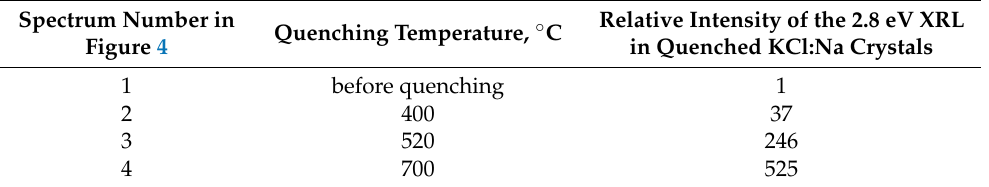
Table 1. Dependence of the peak intensity of XRL with a maximum at 2.8 eV on the quenching temperature of “decayed” KCl:Na crystals (on the basis of Figure 4). Relative Intensity of the 2.8 eV Spectrum Number in Quenching Temperature, ◦ C Figure 4